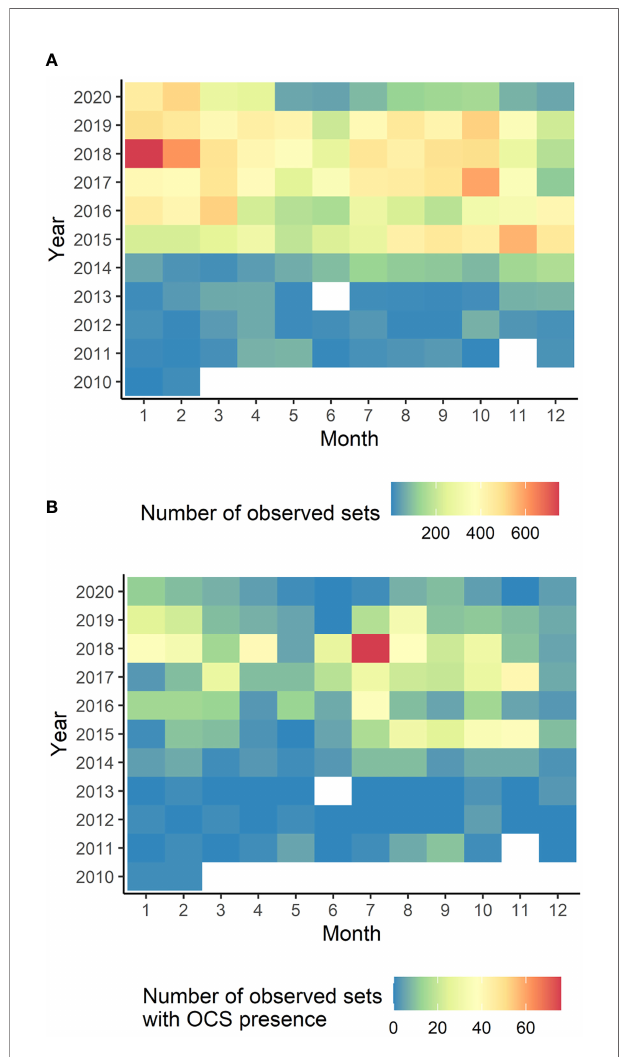
FIGURE 2 | Temporal patterns of the EU and associated fl ags purse seine fi shing activity (observed sets) and observed presences of oceanic whitetip shark catch. (A) Total number of observed sets in the fi shery represented per month between 2010-2020. (B) Total number of sets with presence of oceanic whitetip shark catch per month between